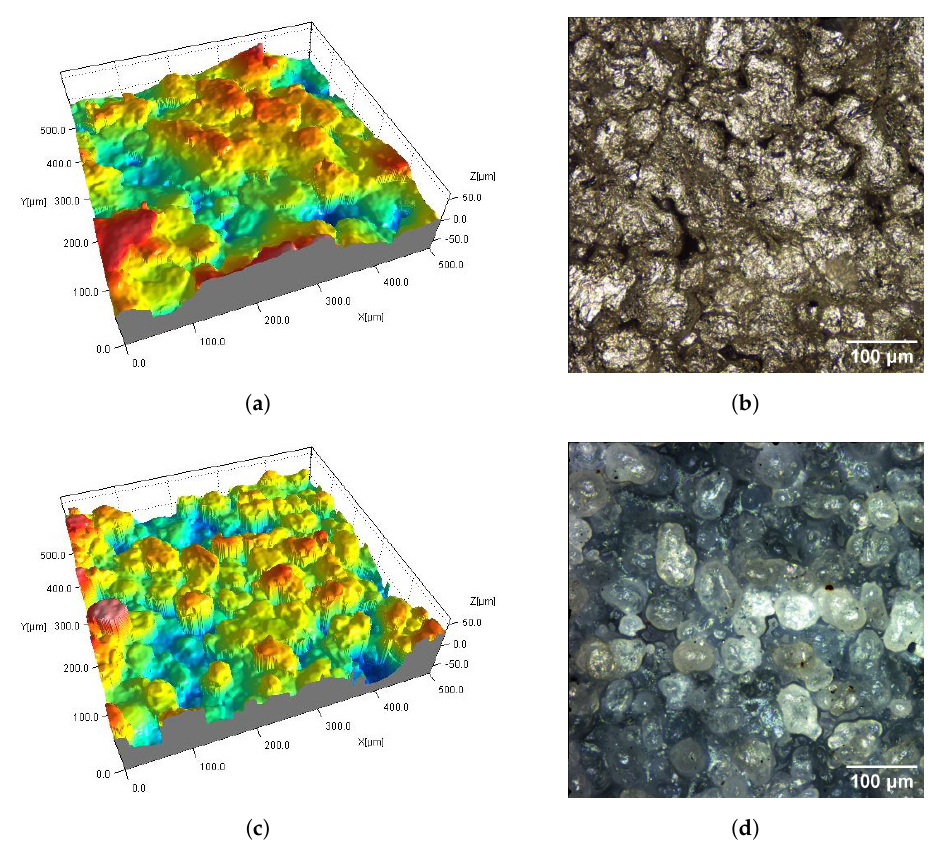
Figure 3. Surfaces of SLS samples with antibacterial coatings AC_Ag ( a , b ) and AC_Glass ( c , d ): fragments 0.5 mm × 0.5 mm of 3D maps ( a , c ) and corresponding 2D views ( b , d